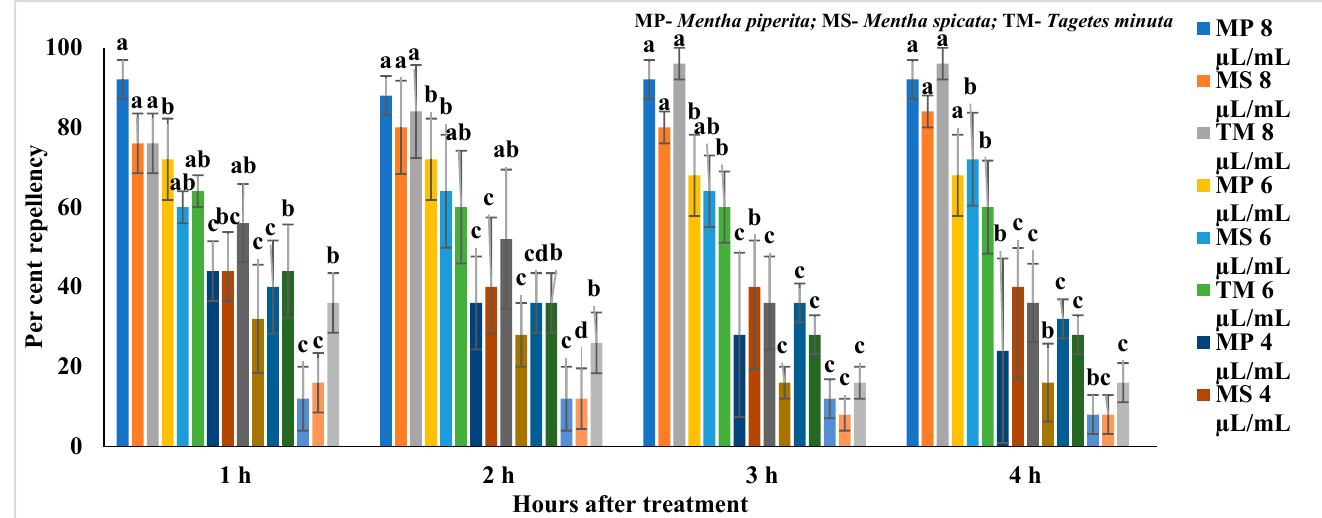
Figure 1. Repellence of essential oils against Callosobruchus chinensis ; Means followed by the same letter within the error bars are not statistically different by Tukey ( p ≤